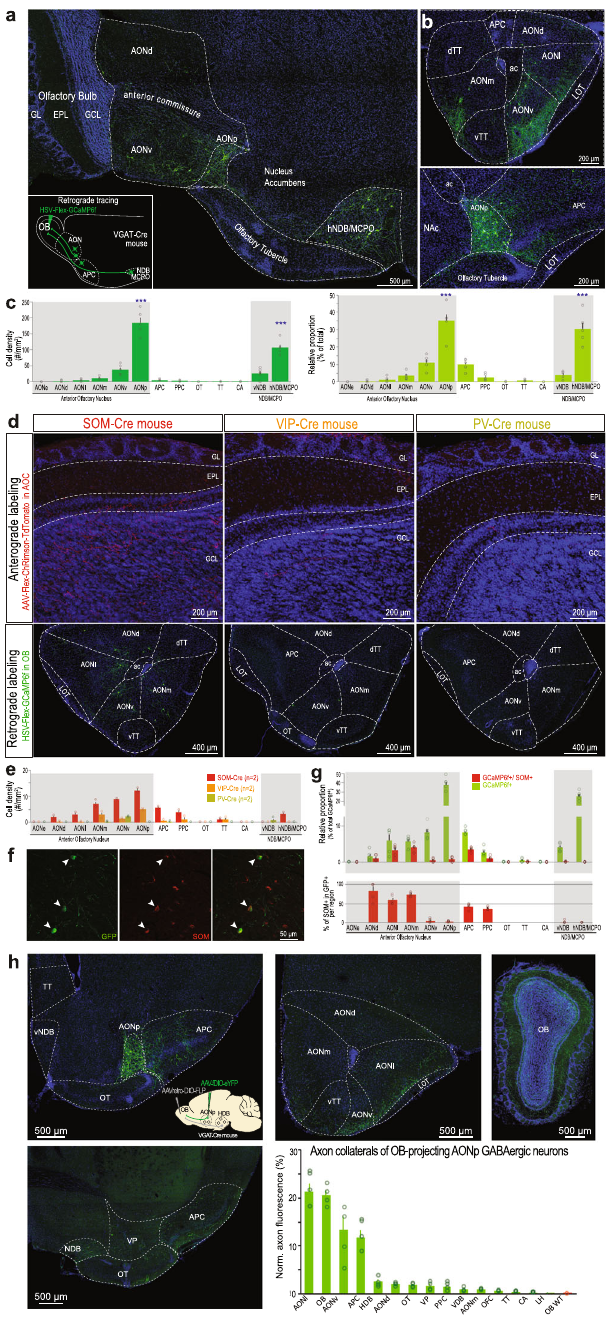
(Fig. 1b). To control for the speci fi c expression of the conditional vectors, we injected the same virus mix in the AOC of wild-type mice and found no expression of the conditional fl uorophore eYFP in the AOC (Supplementary Fig. 1a). In VGAT-Cre mice, viral injection in the AOC infected virtually no somata in the GCL (0.21± 0.11 neurons/mm 2 , n = 6 mice), ruling out any signi fi cant AAV transduction of migrating adult-born neurons 23,44 (Supplementary Fig. 1b – c). Further, to con fi rm the GABAergic nature of the labeled cortical axons in the OB, we injected a conditional virus expressing GFP and Synaptophysin fused with mRuby in the AOC of VGAT-Cre mice. In the OB, synaptohysin- mRuby + presynaptic boutons colocalized extensively with VGAT immunostaining (Fig. 1c).